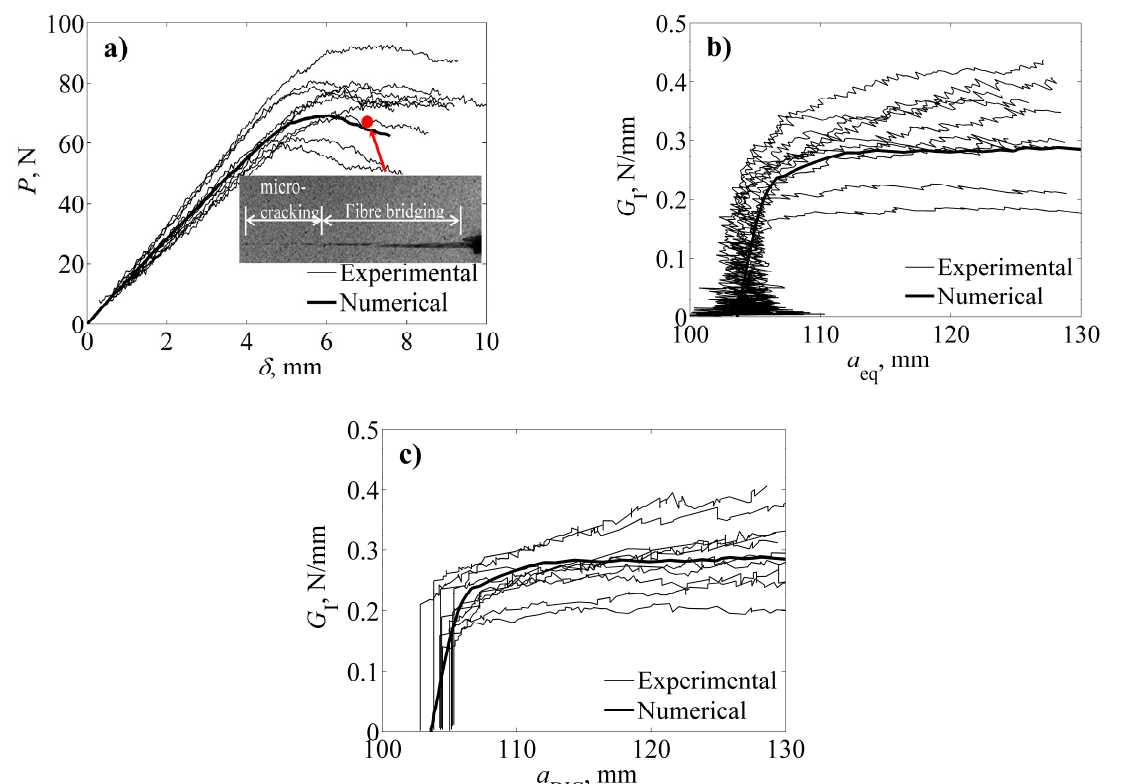
Figure 3: DCB test: (a) curves and macroscopic visualization of the crack propagation; (b) R –curve obtained by CBBM; (c) R –curve obtained by Irwin-Kies